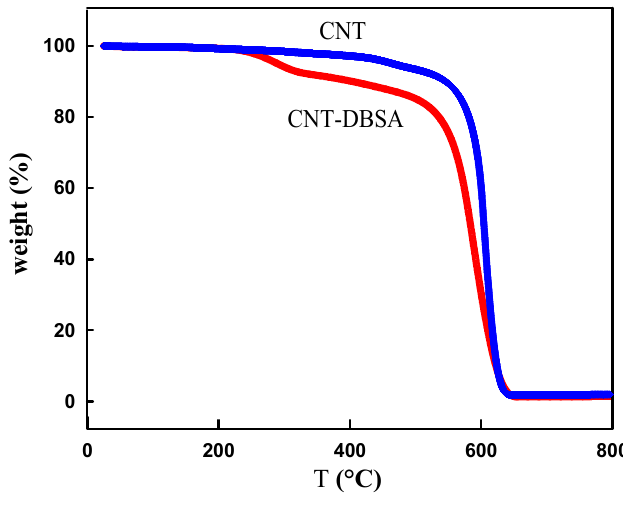
Figure 3. TGA curves of CNTs and CNTs modified by DBSA.